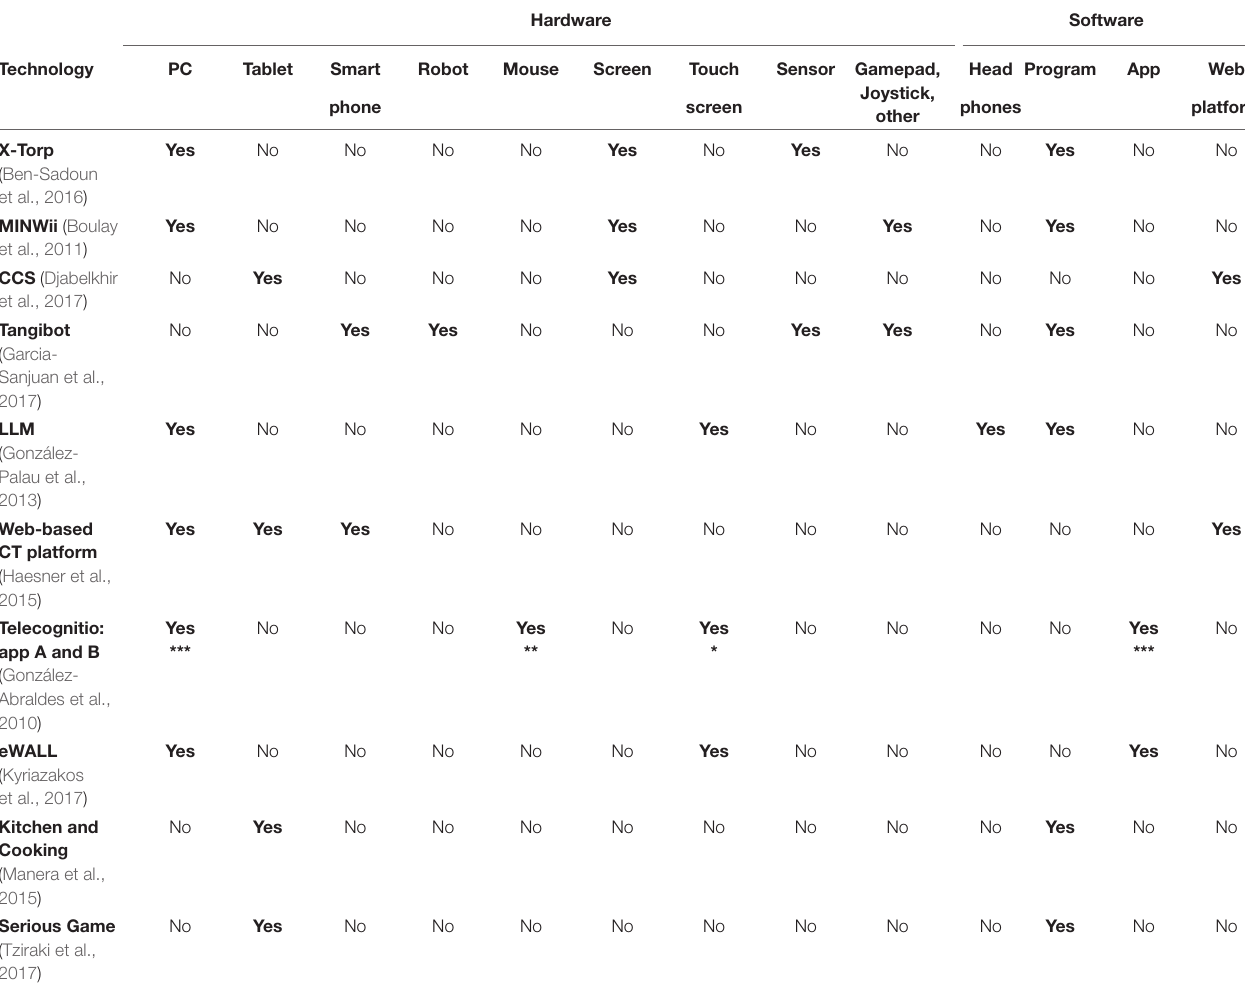
TABLE 4 | Hardware and software of the studies’ cognitive interventions.